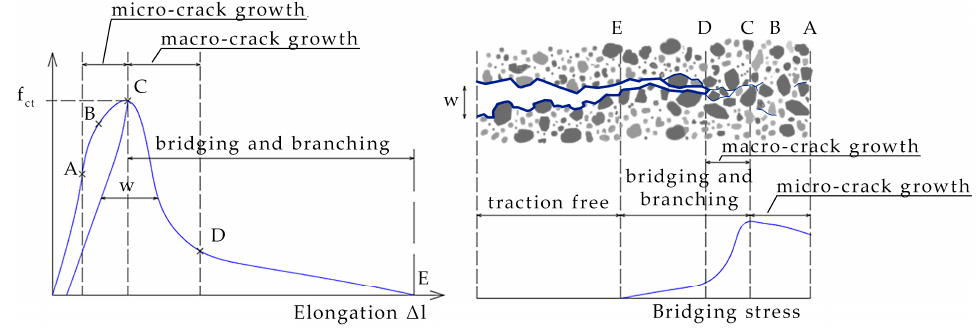
Figure 5. Development of cracks with increasing tensile stresses [71]. The letters in the chart indicate the limits of the zones.